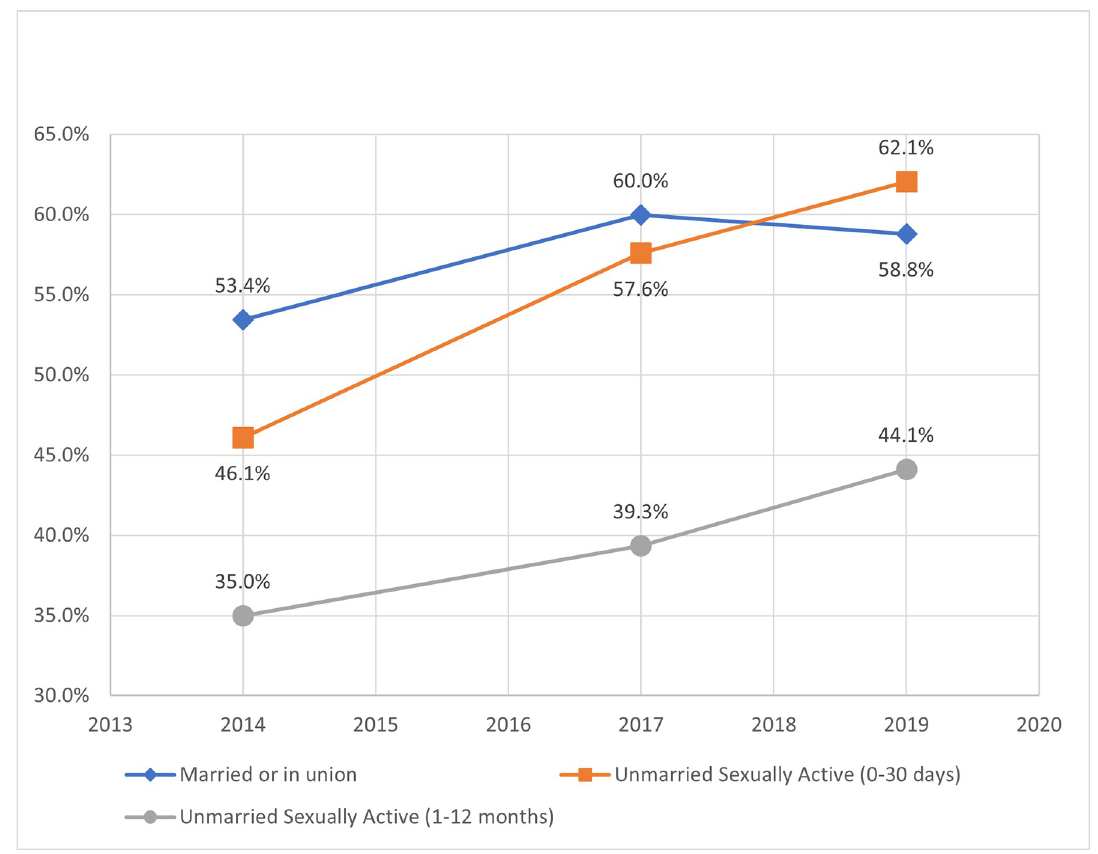
Fig 2. Current modern contraceptive prevalence rate by female